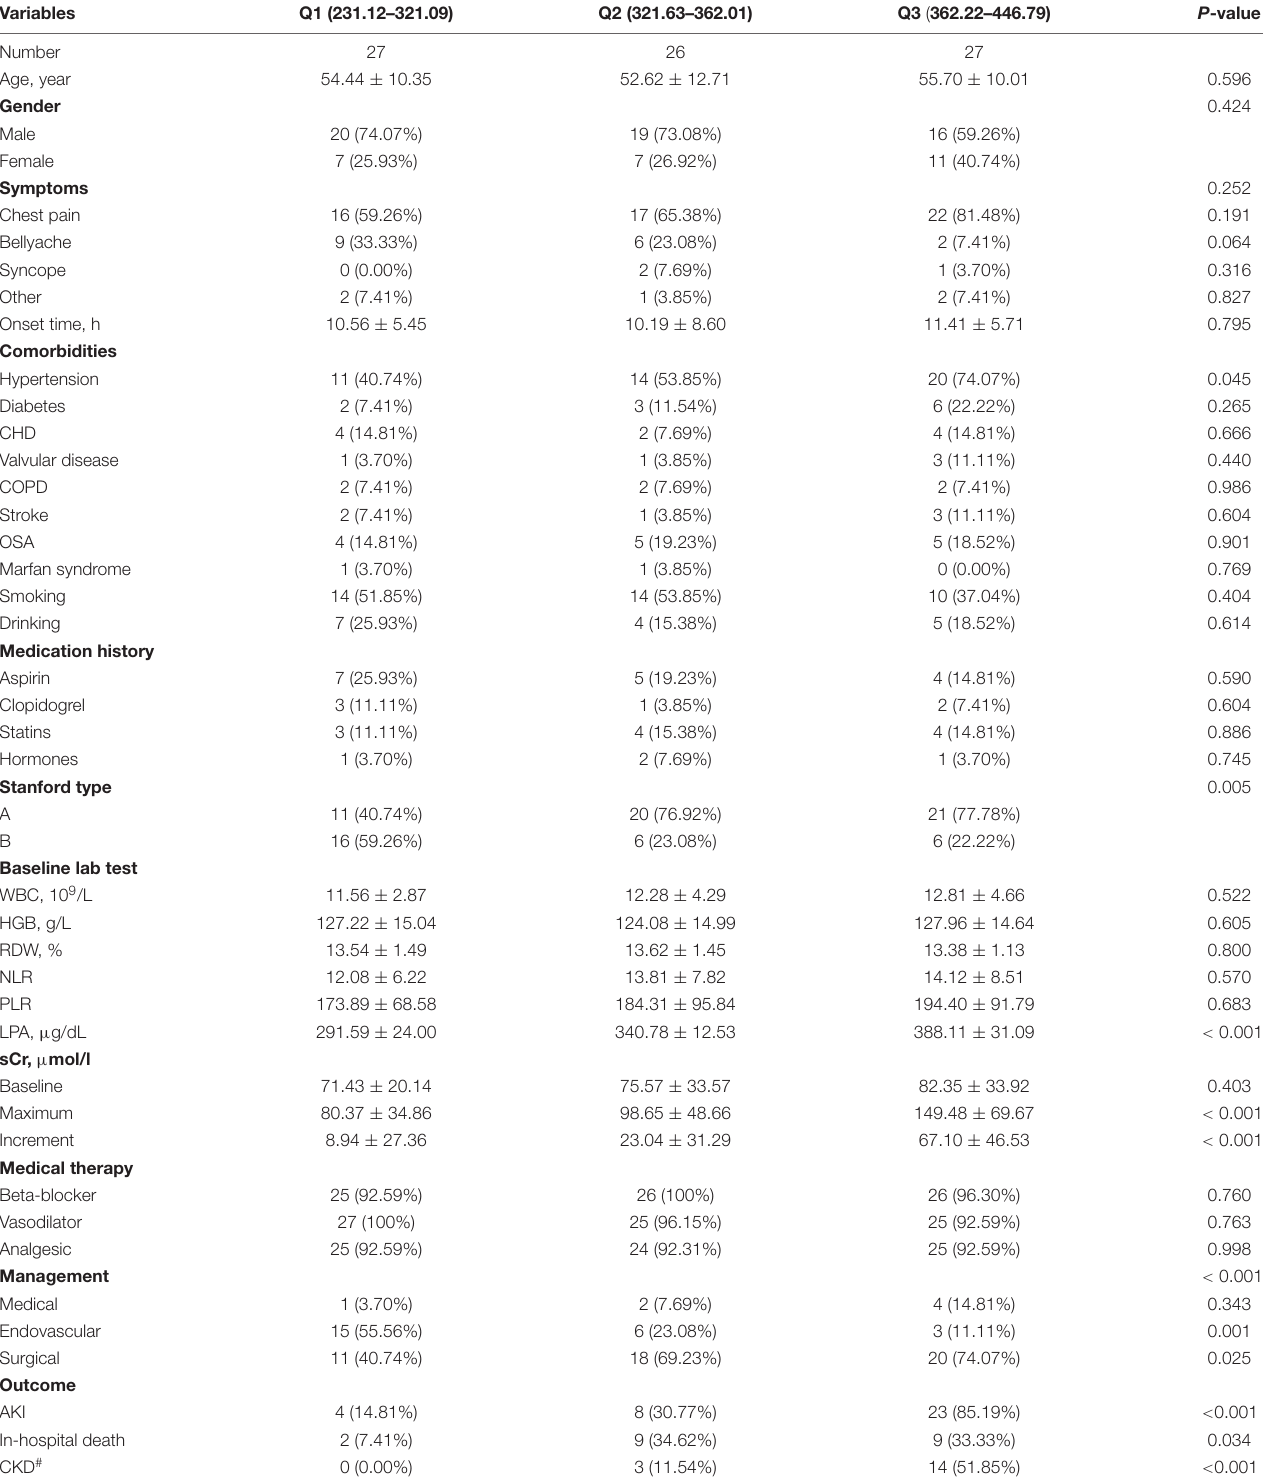
TABLE 1 | Baseline characteristics of the patients about the tertile admission